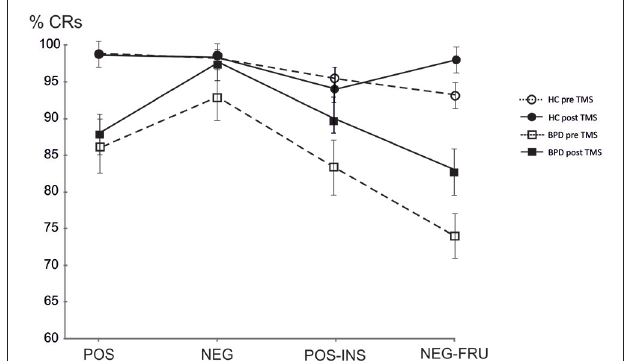
FIGURE 1 | Mean accuracy at the affective Go/No-Go task (AGN) task in healthy controls (HC) and borderline personality disorder (BPD) groups pre and post repetitive transcranial magnetic stimulation (rTMS) in the four blocks. HC pre, Mean accuracy in HC pre rTMS; HC post, Mean accuracy in HC post rTMS; BPD pre, Mean accuracy in BPD pre rTMS; BPD post, Mean accuracy in BPD post rTMS; POS, POSITIVE target category words; NEG, NEGATIVE target category words; POS-INS, POSITIVE-INSECTS target category words; NEG-FRU, NEGATIVE-FRUITS target